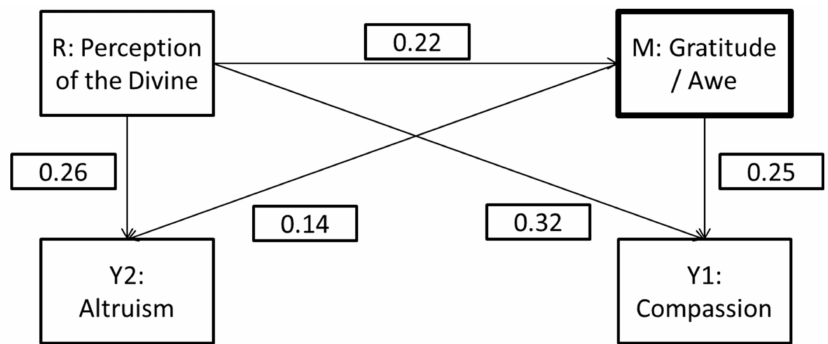
Figure 2. Mediation model (direct model) for Compassion (Y1) and Altruism (Y2) mediated by Gratitude/Awe (M) and the Perception of the Divine as a regressor (R). Scores are β values.